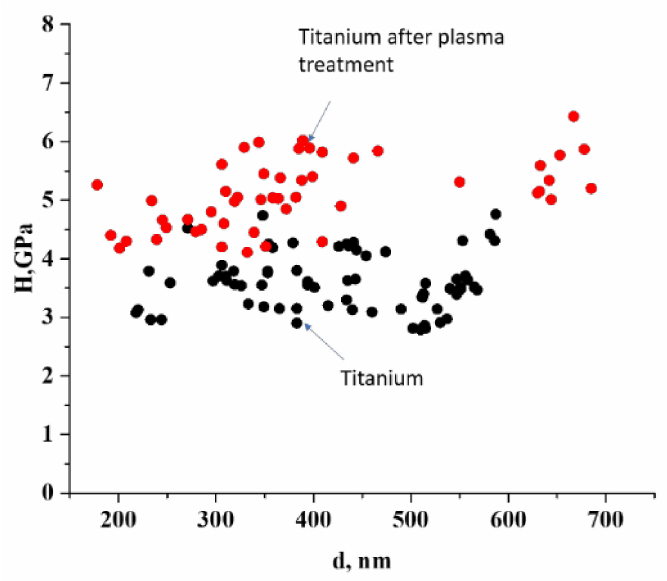
Figure 7. Comparison of the dependence of microhardness on the depth of the titanium surface imprint: initial and after plasma